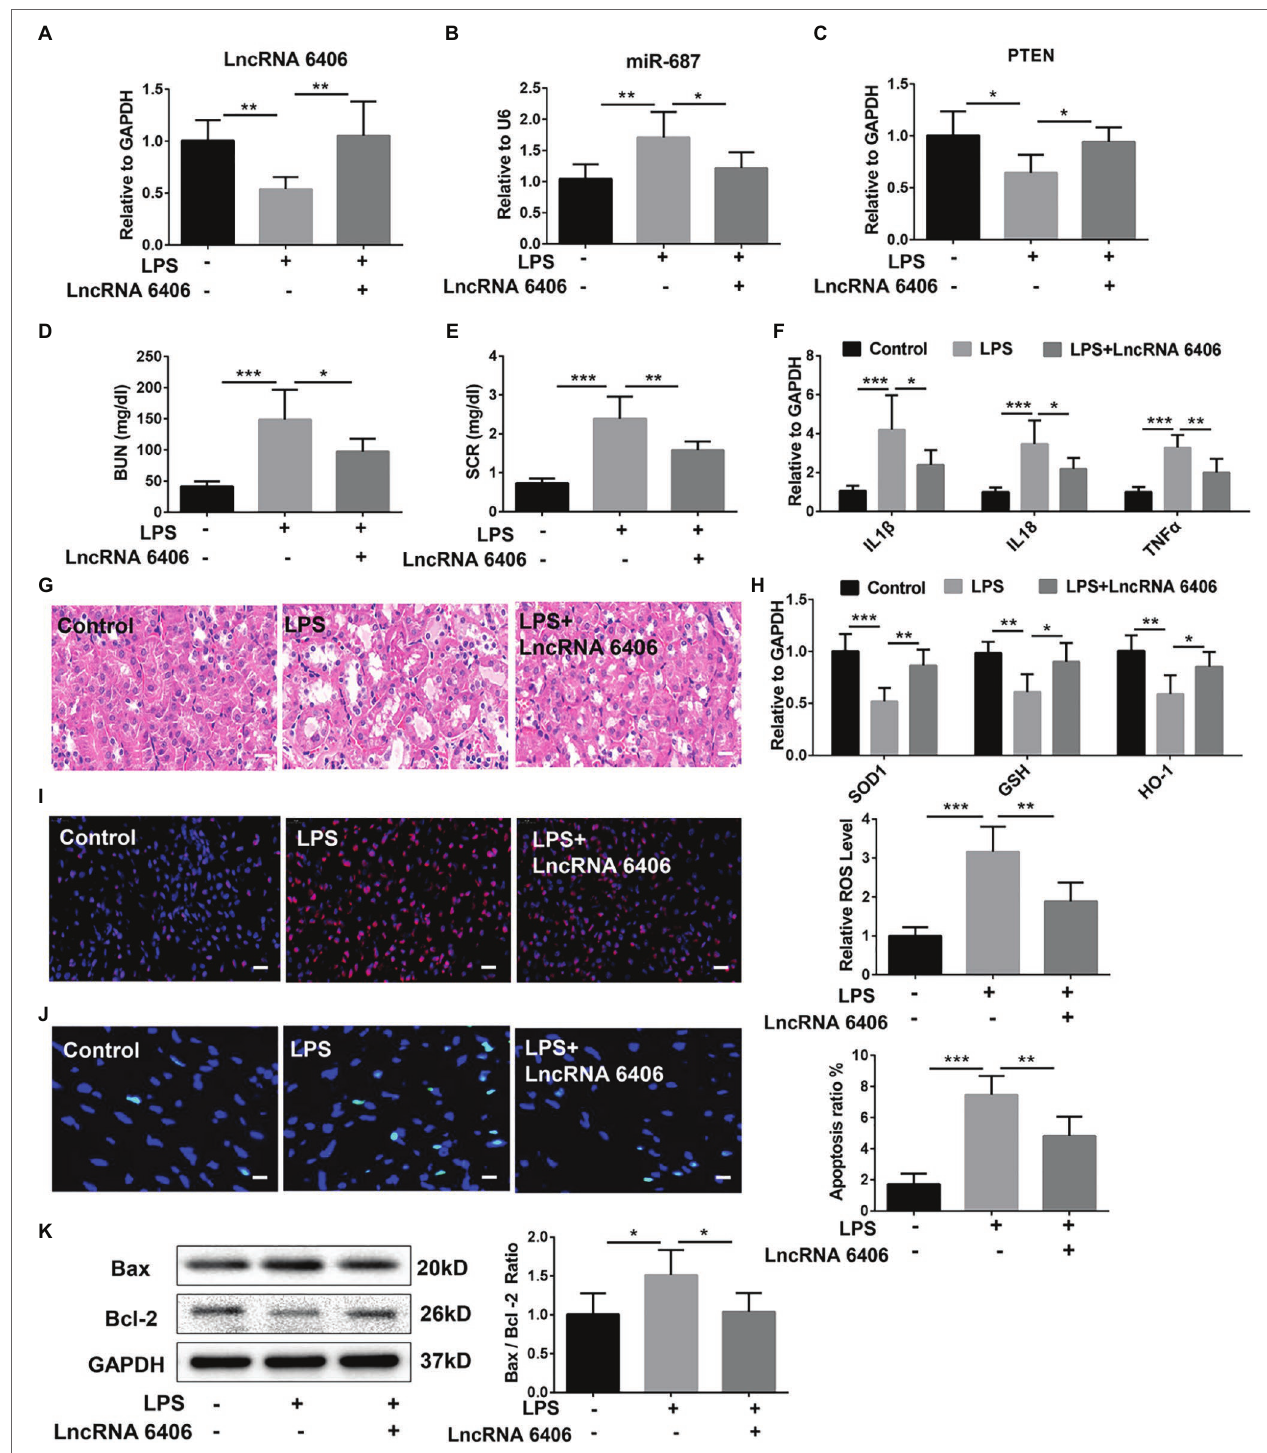
FIGURE 6 | LncRNA 6406 protected against LPS-induced AKI in vivo . (A–C) The relative expression of lncRNA 6406, miR-687 and PTEN was examined via qRT- PCR analysis ( n = 6). (D,E) The difference in blood urea nitrogen (BUN) and serum creatinine (SCR) were detected via ELISA after 24 h of the LPS injection in mice. (F) RT-PCR analysis demonstrated that lncRNA 6406 attenuated the LPS-induced inflammatory response in the kidneys of the AKI mice ( n = 6). (G) LncRNA 6406 improved the outline of renal morphology in LPS-induced AKI, scale bar = 20 μ m. (H,I) RT-PCR analysis and DHE staining revealed that lncRNA 6406 improved the LPS-induced oxidative stress in the kidney ( n = 6), scale bar = 20 μ m. (J,K) LncRNA 6406 decreased the LPS-induced apoptosis in the kidney in vivo ( n = 6), scale bar = 10 μ m. Each experiment was conducted independently three times. *p < 0.05; **p < 0.01; ***p < 0.001; versus respective